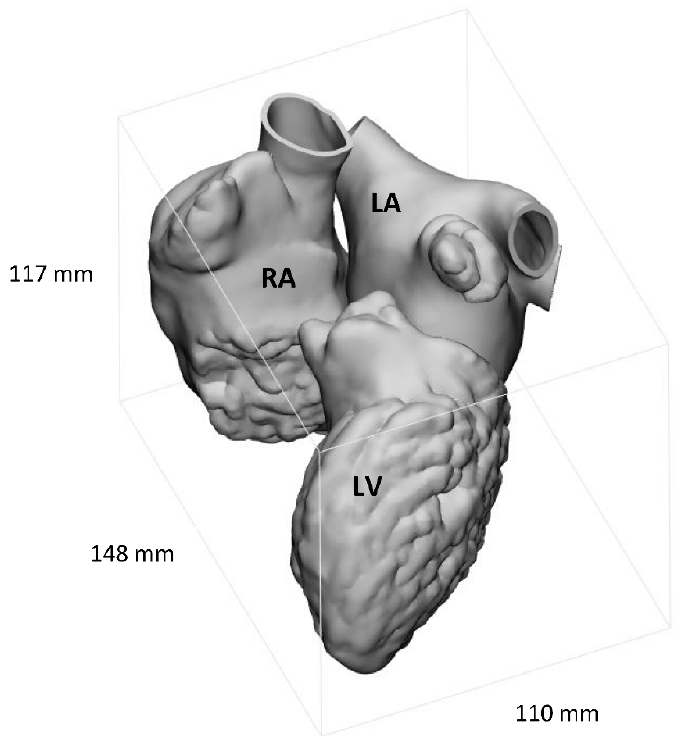
Figure 1. The reconstructed heart model portion, including right atrium (RA), left atrium (LA), and left ventricle (LV). The bounding box with real dimensions (expressed in millimetres) is highlighted.